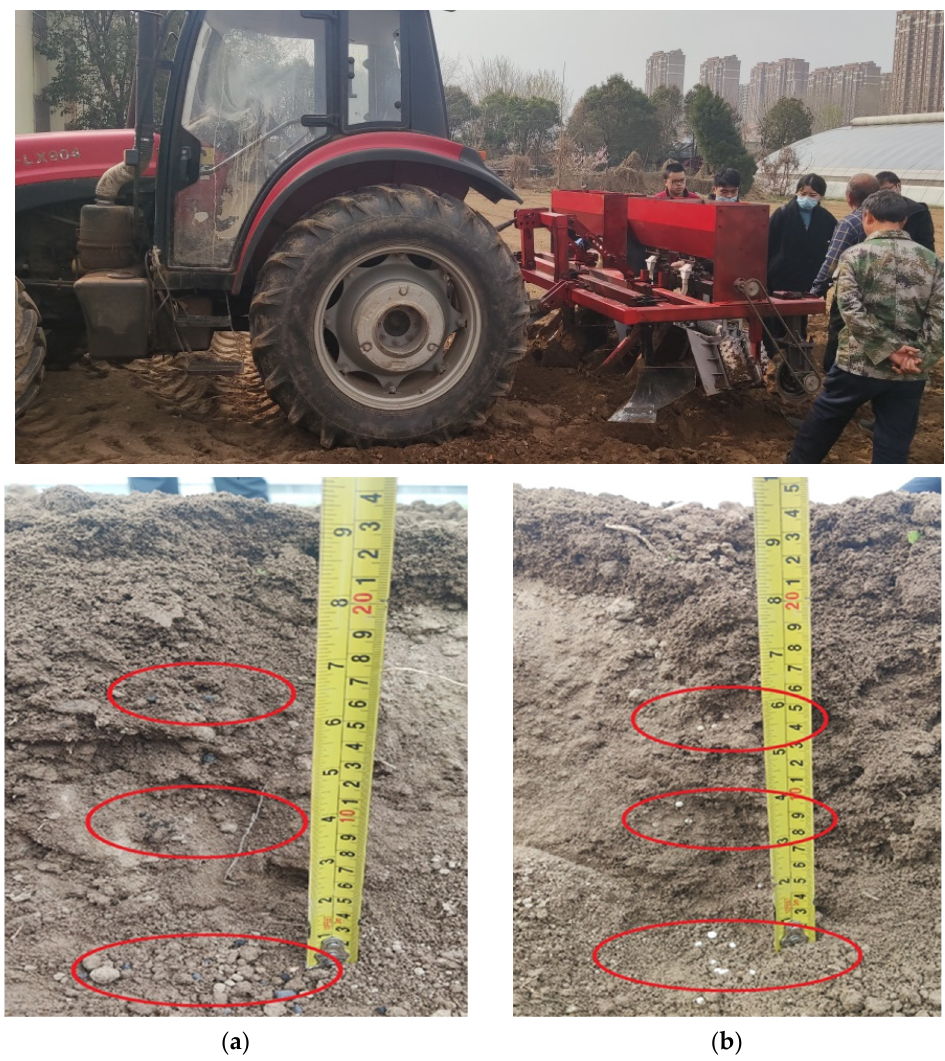
Figure 14. Field test. ( a ) Organic fertilizer, ( b ) Compound fertilizer.